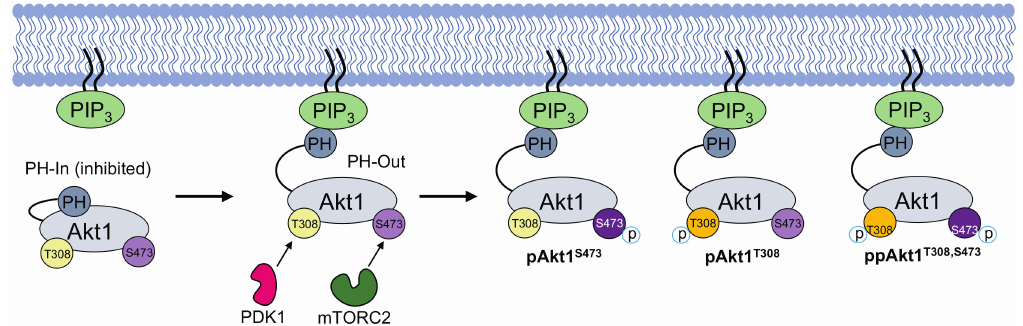
Figure 2. Simplified schematic of protein kinase B (Akt1) activation via phosphorylation of sites Thr308 and Ser473. The transition from Akt1’s inactive state (PH-in) to its fully active state (ppAkt1 T308/S473 ) requires the release of pleckstrin homology (PH) domain–mediated auto-inhibition. This release occurs when Akt1’s PH domain interacts with PIP 3 (PH-out). In the PH-out conformation, Akt1 is more susceptible to phosphorylation at Thr308 and Ser473 by phosphoinositide dependent kinase 1 (PDK1) and mechanistic target of rapamycin complex 2 (mTORC2), respectively. Upon release from PIP 3 , Akt1 distributes rapidly in the cytosol and translocates to the nucleus to phosphorylate >100 cellular proteins